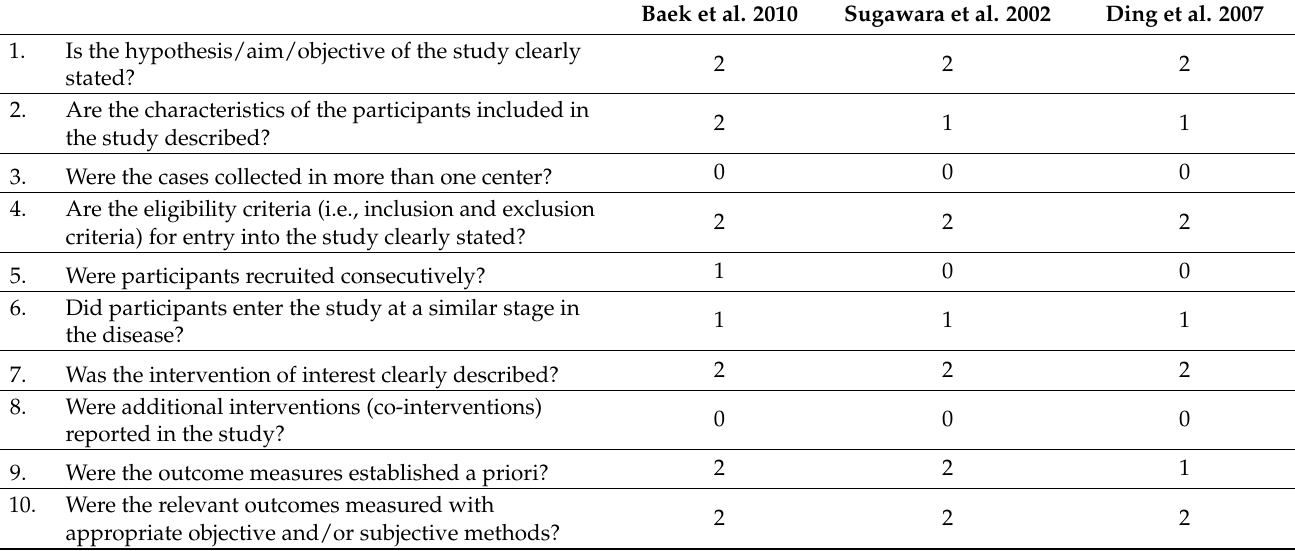
Table 4. Assessment of the risk of bias in the included articles by the Institute of Health Economics (IHE) Appraisal Tool. Baek et al.